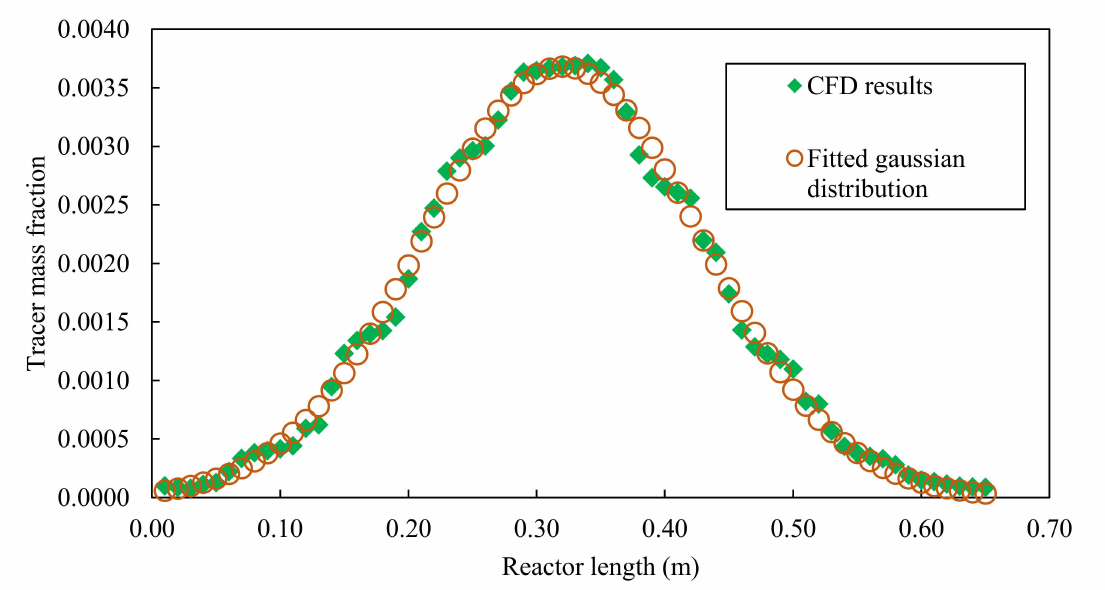
Figure 10. Axial distribution of tracer concentration in t = 1s for 40 mm of oscillation amplitude and 2 Hz of oscillation